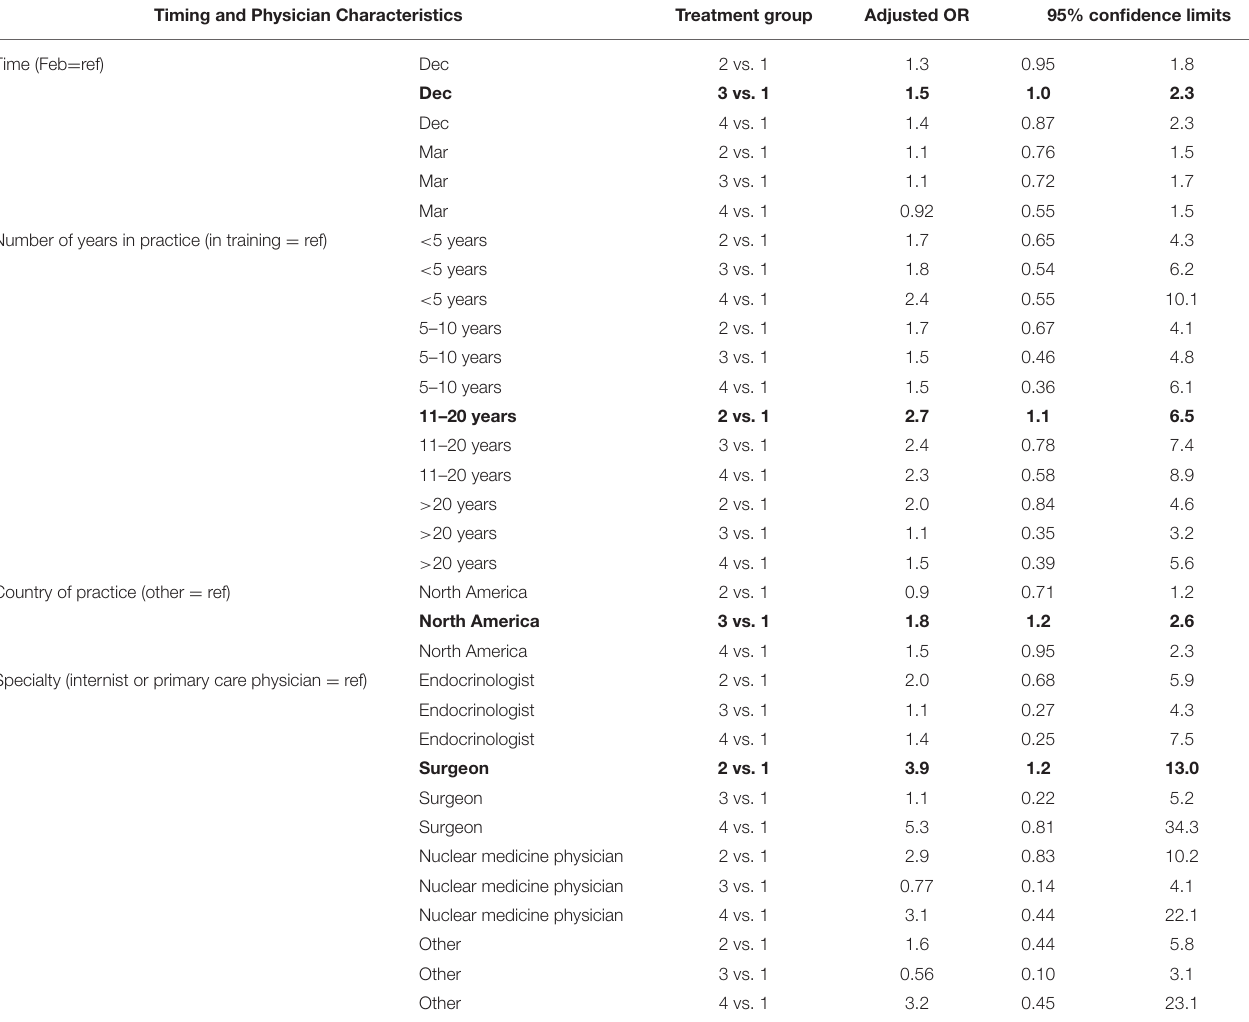
TABLE 6 | Multivariate analysis of the effect of timing on physician prescribing continued LT4 vs. increasing LT4 vs. adding LT3 to LT4 vs. replacing LT4 with T3-containing